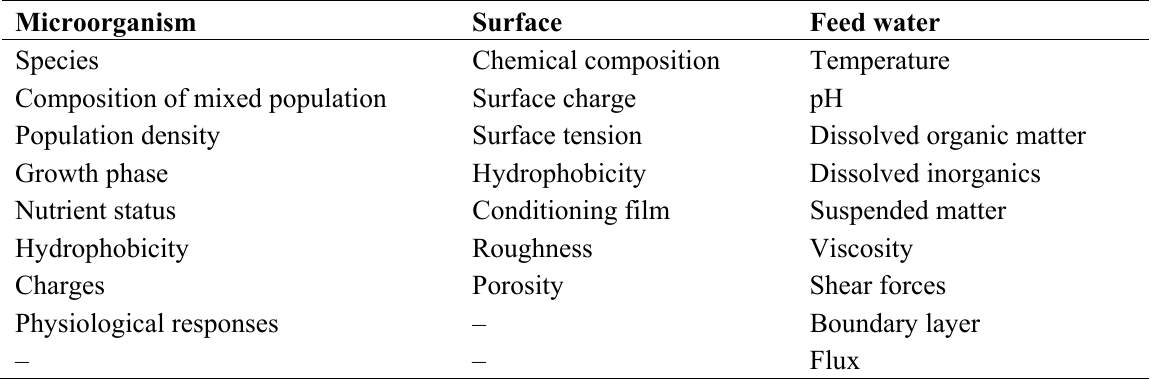
Table 1. Factors affecting microorganism adhesion to membrane surfaces